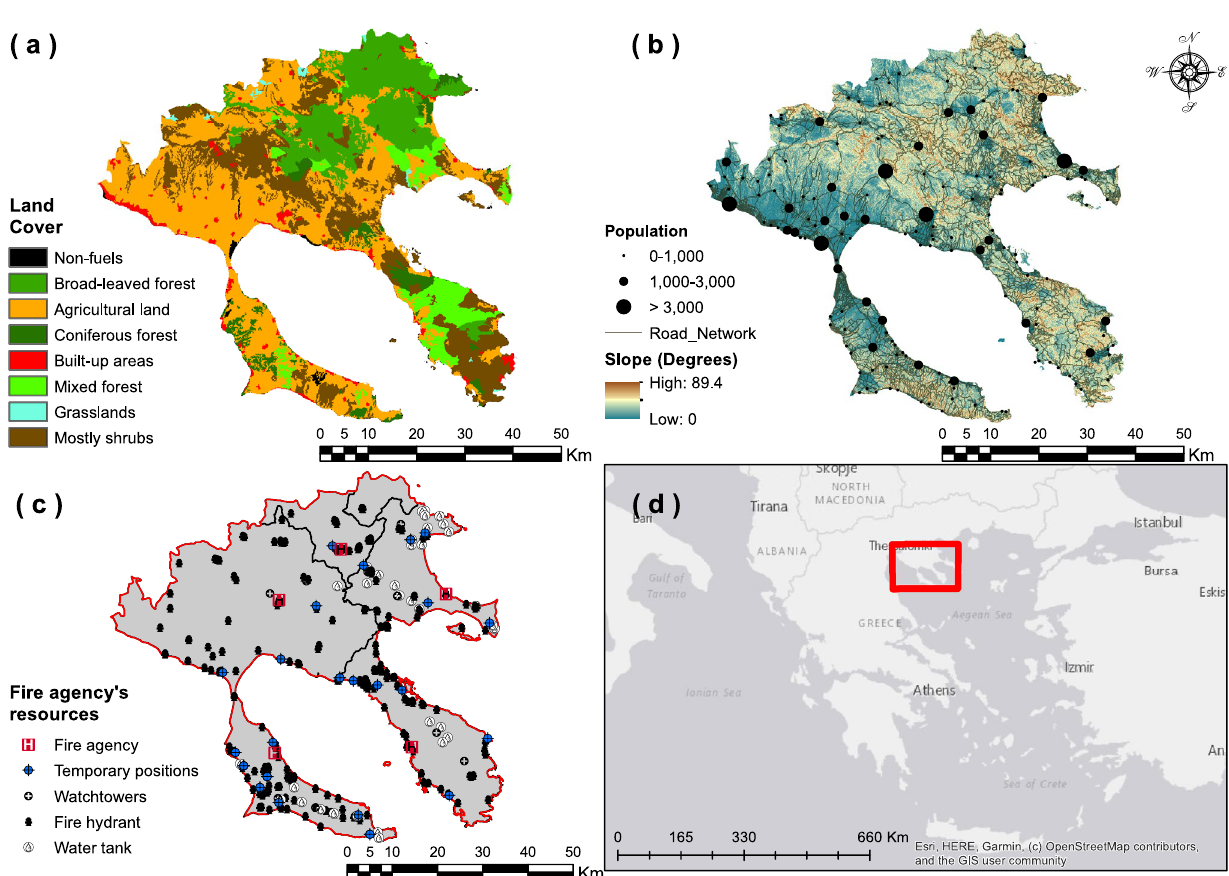
Fig. 1 The Chalkidiki Prefecture study area in Greece. a Land cover distribution; b Spatial distribution of the road and residential network in conjunction with slope; c Firefighting resources distribution; d Geographical location of the study area (red rectangle). Data sources